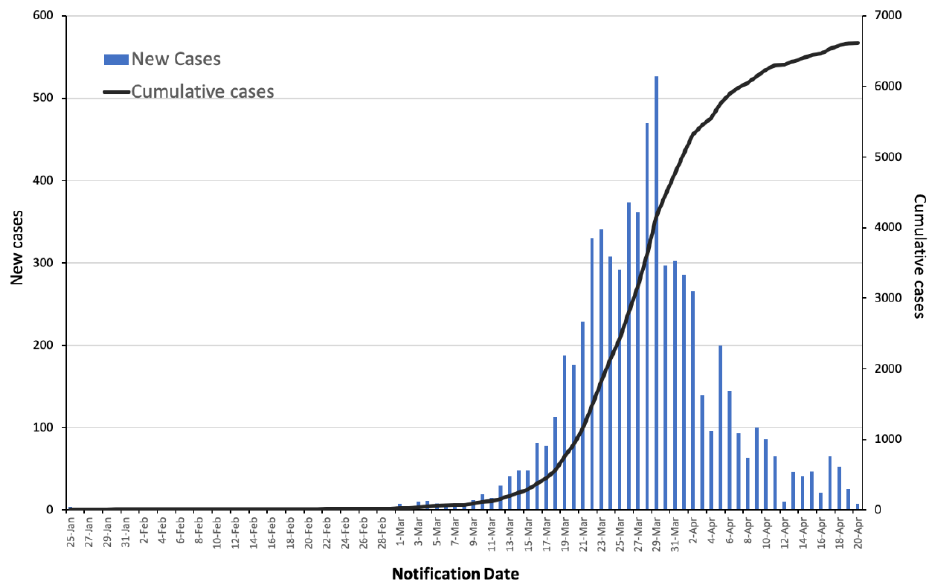
Figure 1. New and cumulative reported COVID-19 cases. Data retrieved from the Australian